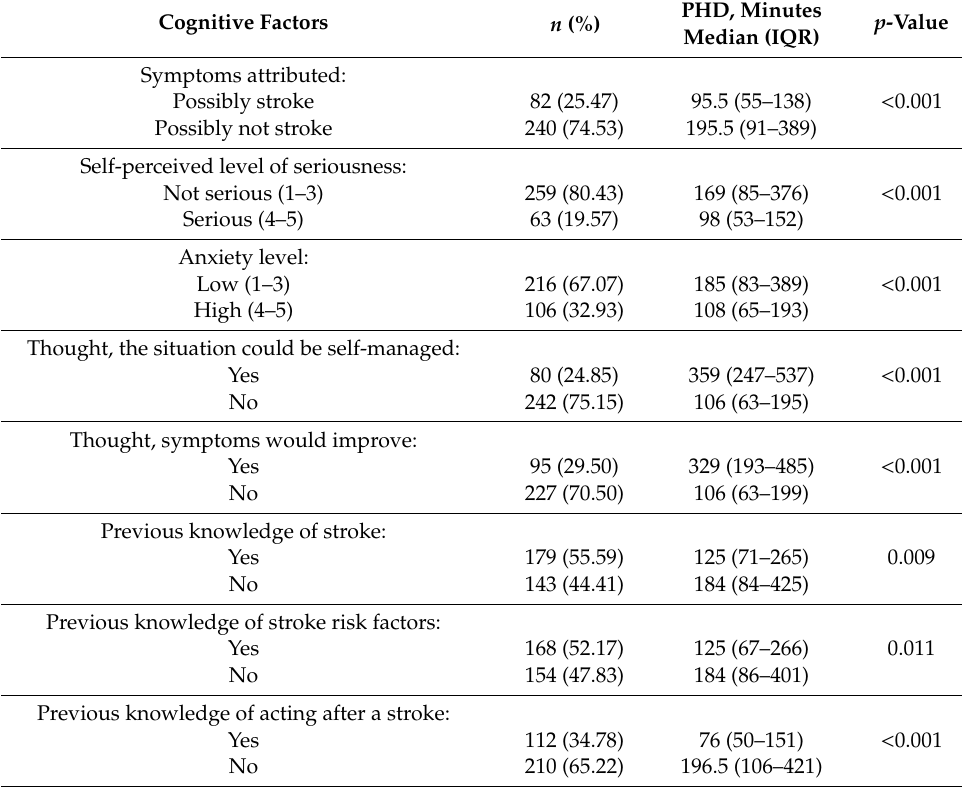
Table 4. Time from the symptom onset to hospital arrival by cognitive